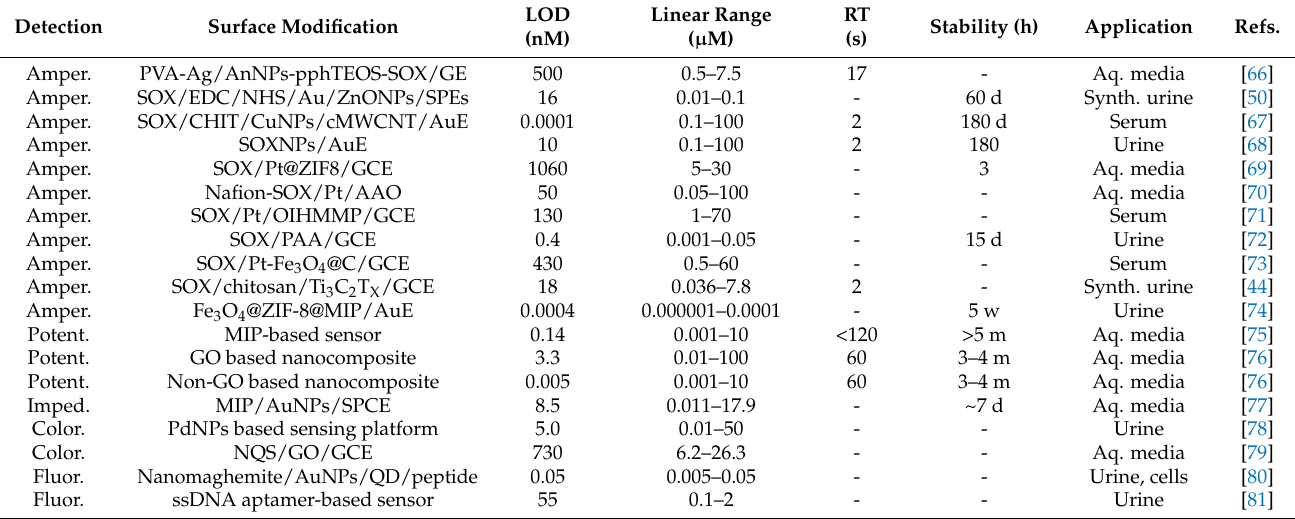
Table 1. Basic operational parameters for sensors detecting